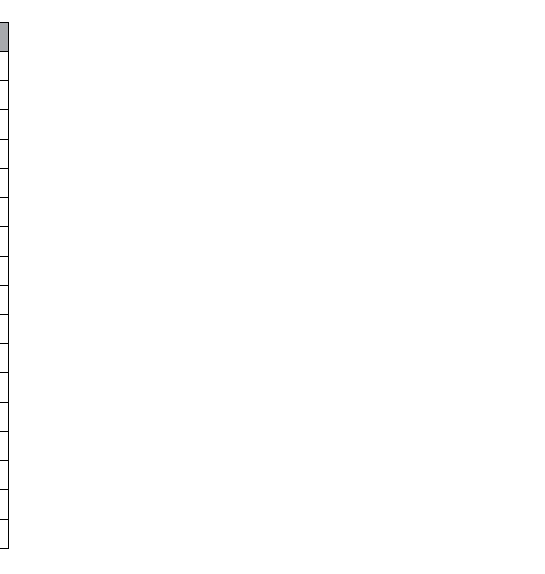
Table 1. Targeted mineralogical composition of eco-friendly cement, dosages of raw materials and oxide composition of the obtained mixtures (excluding H 2 O and CO 2 ).